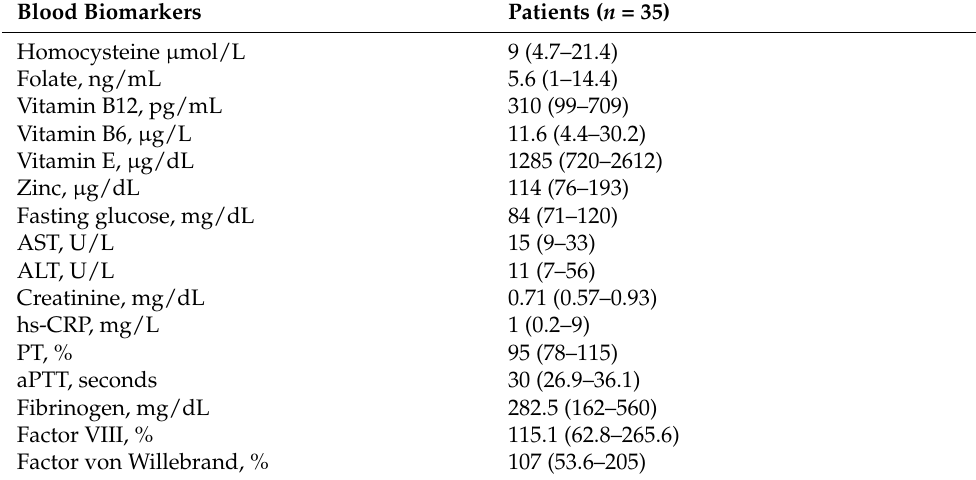
Table 2. Biochemical Parameters at